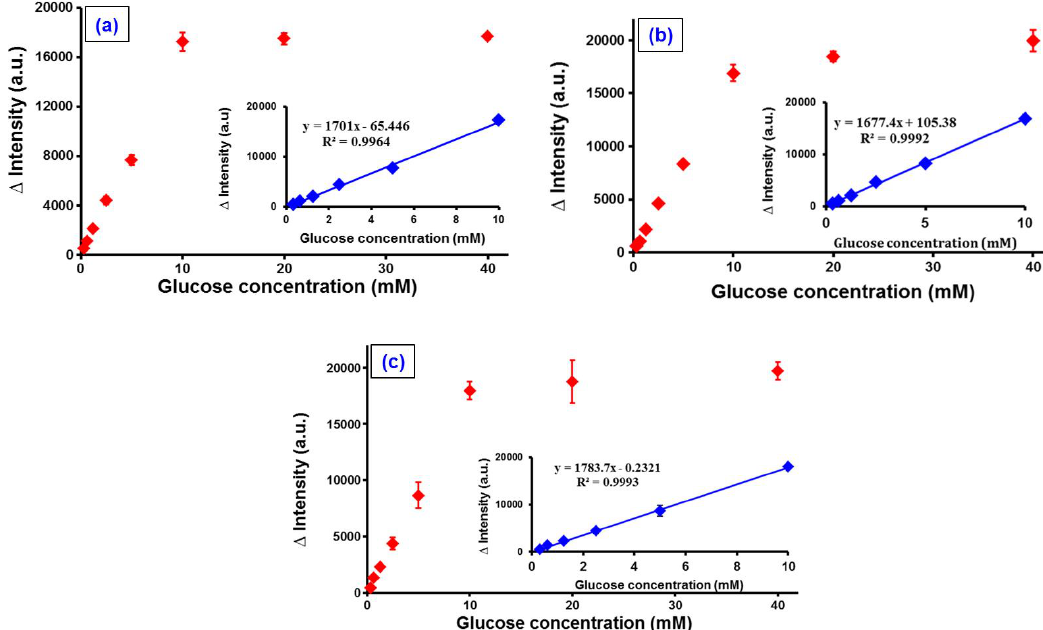
Figure 7. Fluorescence intensity of CdSe/ZnS-capped TGA core shell QDs via various glucose levels from 0 to 40 mM. The inset shows the relationship between intensity and glucose concentration. The calibration curves were produced in triplicate (( a – c ) labels in the figure corresponds to the repetition thrice) using different batches of CdSe/ZnS.